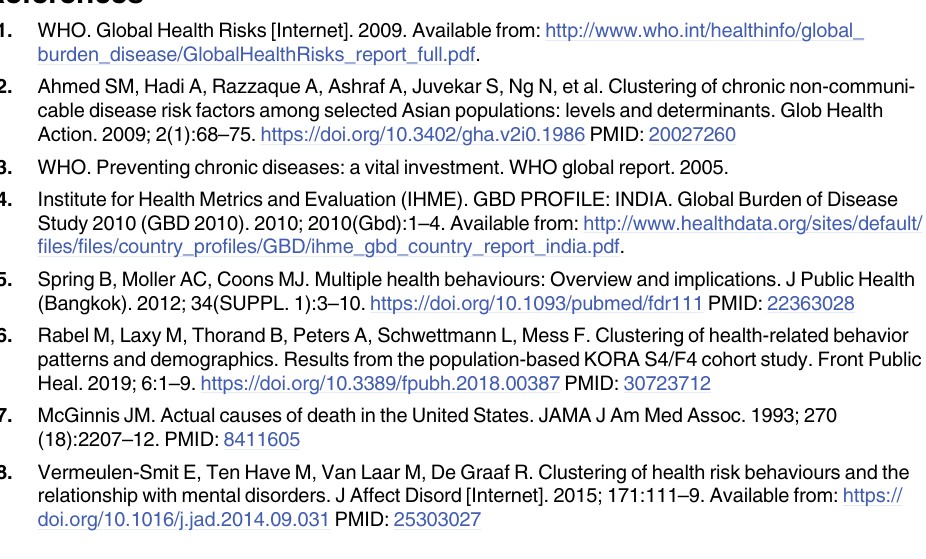
S1 Table. Distribution of lifestyle risk factor among adult